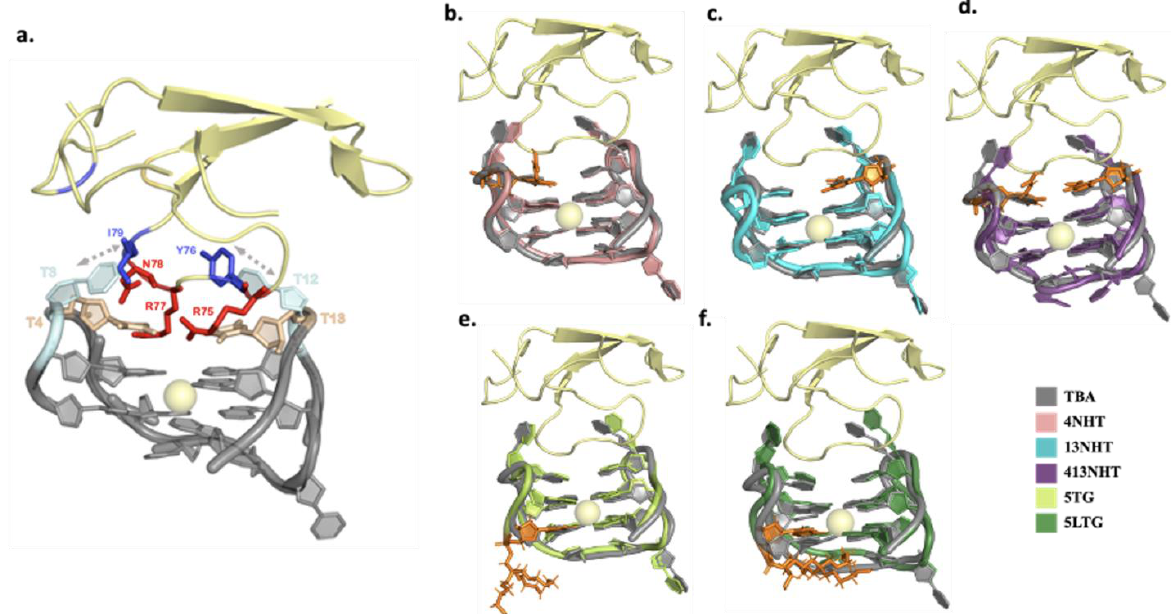
Figure 5. Structures of thrombin bound aptamers. The protein and the potassium ion are shown in yellow and the unmodified aptamer in gray ( a ) The aminoacid residues and nucleotides involved in the interaction between thrombin and the unmodified aptamer (hydrophobic interactions in shades of blue, and hydrophilic in red and wheat) ( b – f ) Structures of the dominant conformation from the simulations for the modified aptamer systems overlaid on the unmodified aptamer (gray). The modified nucleotides in each case are highlighted in orange.